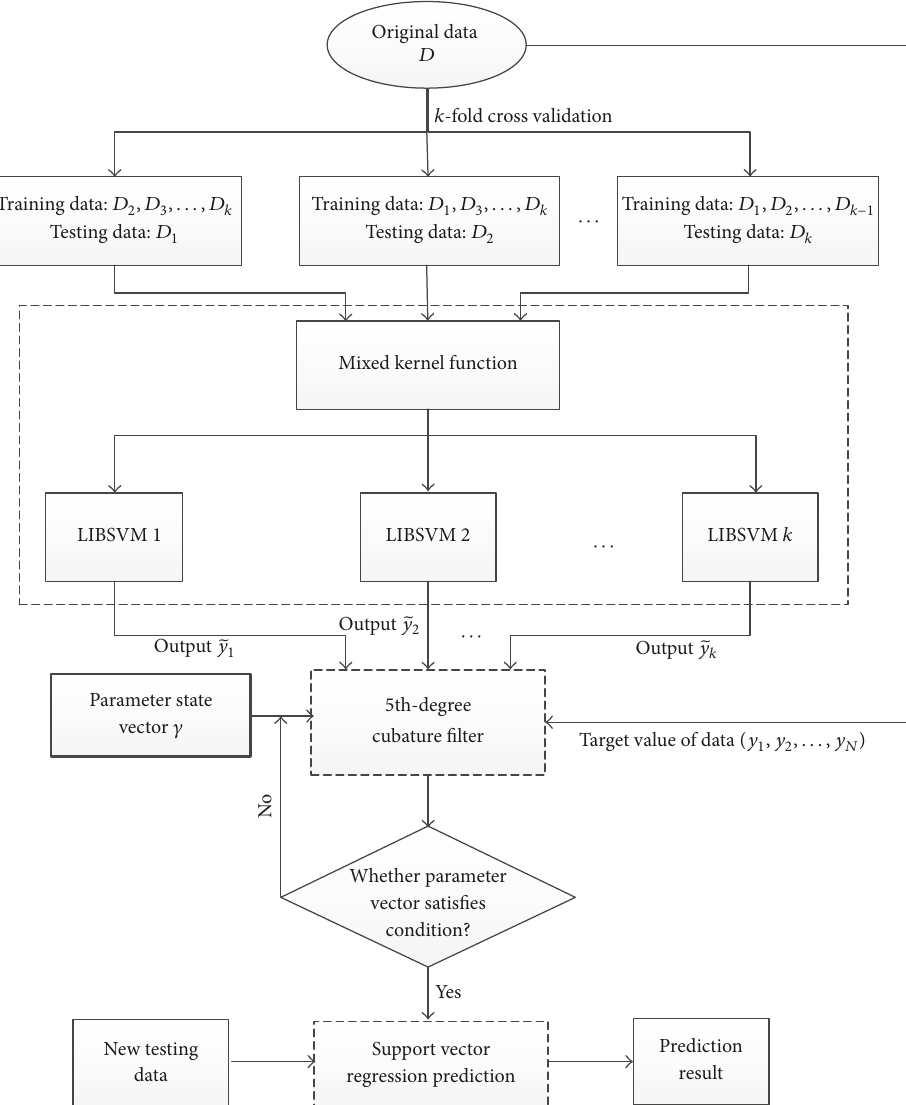
Figure 2: Parameter adjustment structure of support vector regression based on adaptive fusion of the mixed kernel